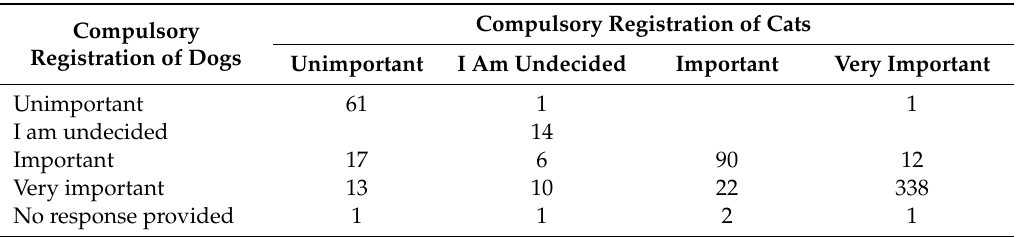
Table 8. Numbers of the 590 respondents by views about the importance of compulsory registration of dogs and cats by local councils for controlling domestic (owned) dog and